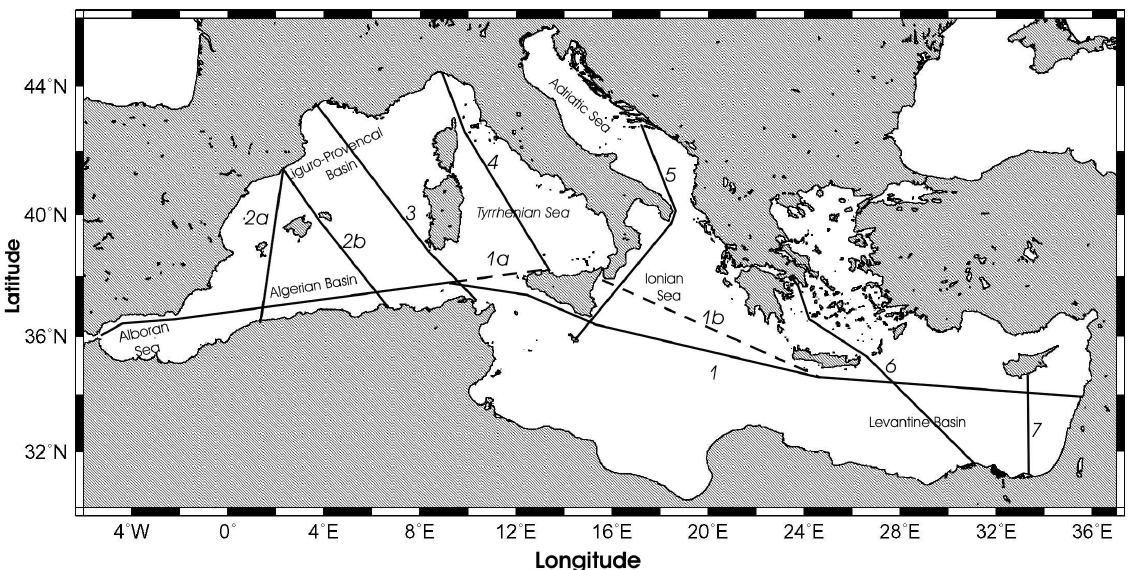
Fig. 2. The Mediterranean Sea and the ship-of-opportunity tracks (straight lines) carried out in the framework of MFS. Each track is identified with a number (see also Table